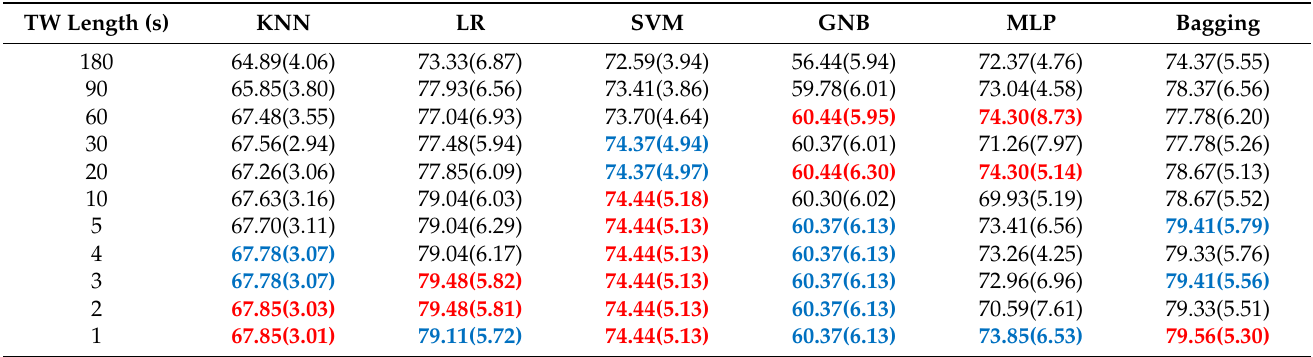
Table 7. The recognition results (mean accuracy and standard deviation) of PSD features extracted from separate frequency bands when using different classifiers under different TW lengths with ELBN. The highest and second-highest accuracies of each classifier are highlighted in bold red and bold blue, respectively.